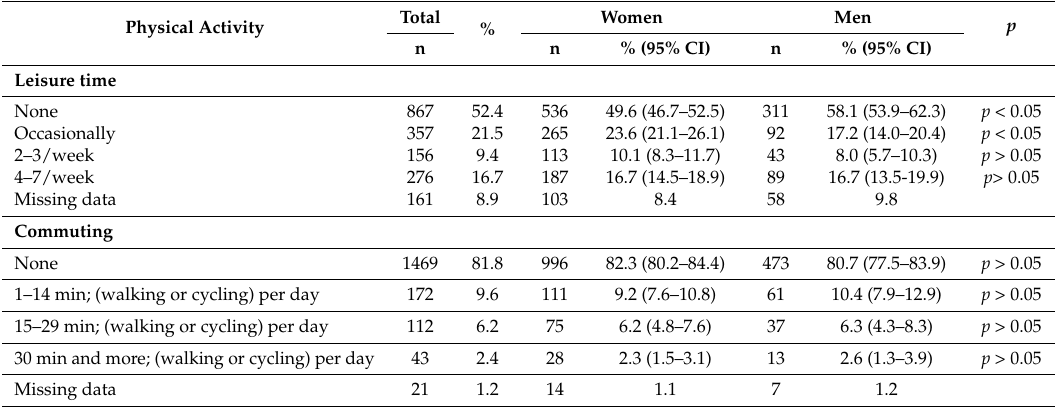
Table 2. Physical activity characteristics of the study sample ( n = 1817).